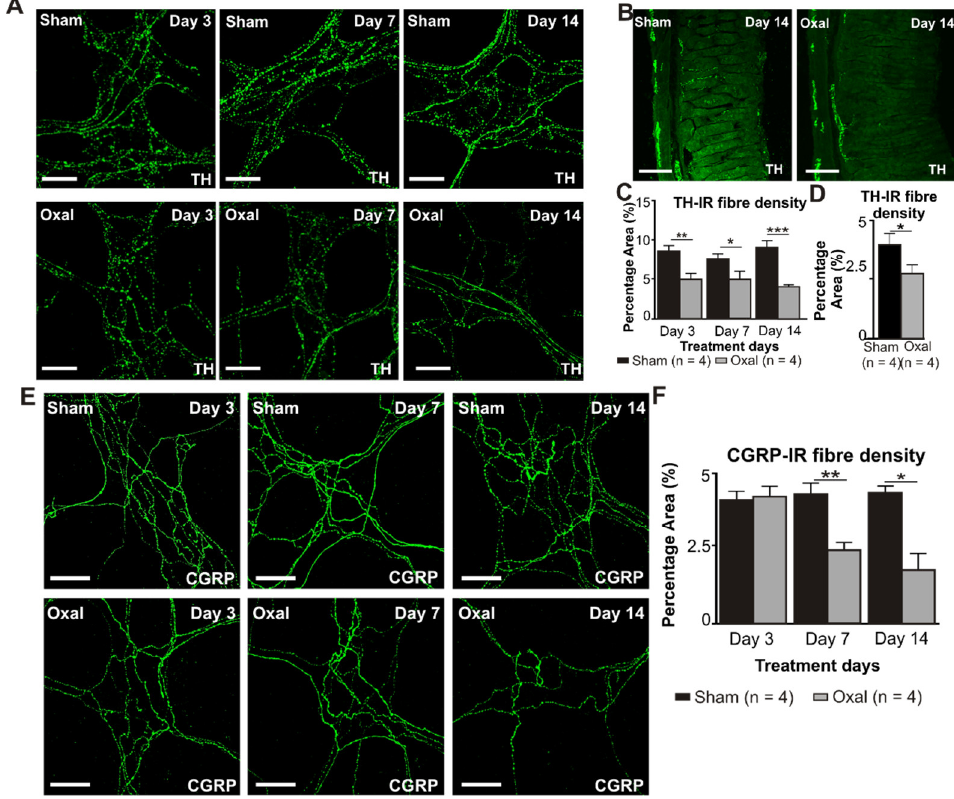
Figure 6. Effects of chronic oxaliplatin treatment on noradrenergic and sensory nerve fibres in the stomach. ( A ) Noradrenergic fibres labelled with tyrosine hydroxylase (TH) in wholemount prepa- rations of myenteric ganglia of the gastric corpus at days 3, 7, and 14 following the injection of sterile water (sham) and oxaliplatin (oxal). Scale bar: 100 µm. ( B ) Noradrenergic fibres labelled with TH in cross-section preparations of the gastric corpus at day 14 following the injection of sterile water (sham) and oxaliplatin (oxal). Scale bar: 100 µm. ( C ) Group data showing the density of the TH-IR fibres per 0.25 mm 2 area in wholemount preparations of the gastric corpus of sham and oxal-treated mice. ( D ) Group data showing the density of the TH-IR fibres in cross-section preparations of the gastric corpus of sham and oxal-treated mice. ( E ) Sensory nerve fibres labelled with calcitonin gene- related peptide (CGRP) in wholemount preparations of myenteric ganglia at days 3, 7, and 14 fol- lowing the injection of sterile water (sham) and oxaliplatin (oxal). Scale bar: 100 µm. ( F ) Group data showing the density of the CGRP-IR fibres per 0.25 mm 2 area in wholemount preparations of the stomach of sham and oxal-treated mice. Data are presented as the mean ± SEM. The number of animals is shown in parentheses. *** p < 0.001; ** p < 0.01; * p < 0.05. Immunolabelling using the anti-CGRP antibody was performed to assess sensory (CGRP-IR) nerve fibres in the gastric corpus. CGRP-IR nerve fibres were distributed throughout the mucosa and myenteric plexuses of the gastric corpus. Repeated oxaliplatin administration caused a significant decrease in the percentage area of CGRP-IR fibres at day 7 (2.4 ± 0.3%, p < 0.01) and 14 (1.8 ± 0.6%, p < 0.05) in wholemount LMMP preparations of the stomach compared to the sham-treated group (day 7: 4.3 ± 0.2%; day 14: 4.3 ± 0.05%;